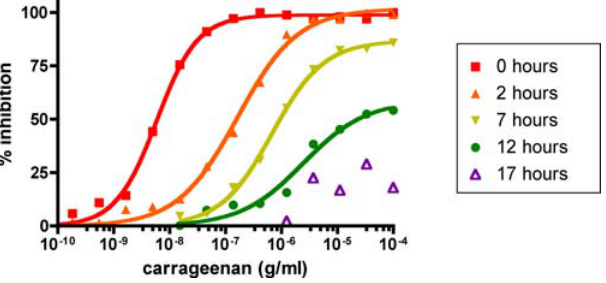
Figure 5. Carrageenan Addition Time Course Cells were incubated with HPV16 PsV for 2 h, followed by washout of the virus inoculum. Carrageenan was added at the timepoints shown, where time zero represents initial PsV inoculation. DOI: